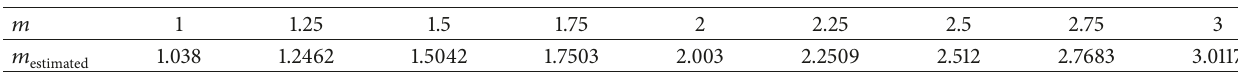
Table 2: Comparison between parameter 𝑚 value obtained by Matlab simulation over 𝑁 = 1000000 samples of Nakagami- 𝑚 vector 𝑧 and value of 𝑚 parameter estimated by using (6) from this letter ( 𝑧 1 = mean (𝑧) , 𝑧 2 = mean (𝑧) − var (𝑧) , and Ω = 𝐸(𝑧 2 ) ).